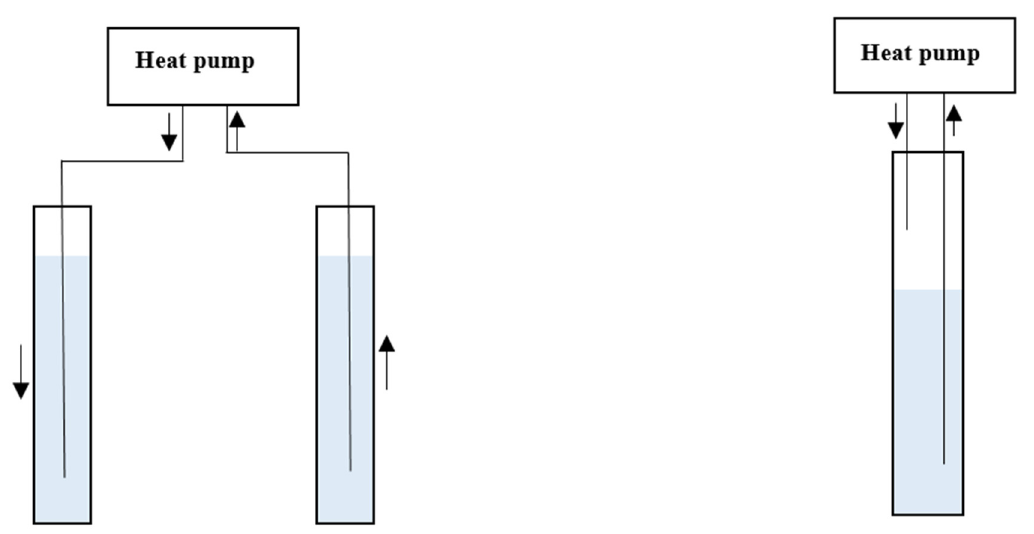
Figure 2. Schematics of different open ground heat exchangers.